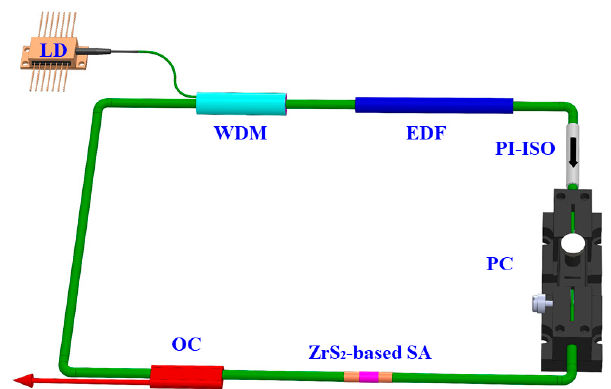
Figure 3. Setup of the EDF laser with ZrS 2 -based SA.